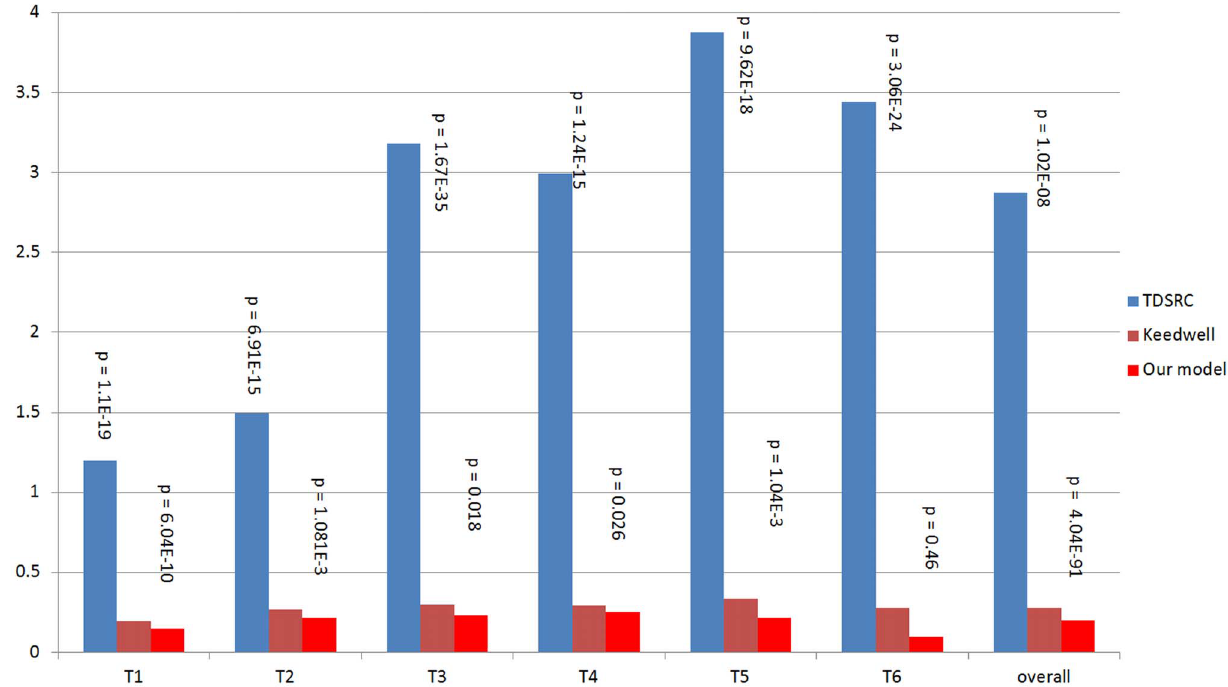
Figure 7. Comparison of fitness to microarray data. Fitness of our model is compared to that of the Keedwell et al. model and the TDSRC model on our microarray dataset. Fitness is significantly better (p , 0.05) in 4 out of 6 time points and for all time points combined (overall).